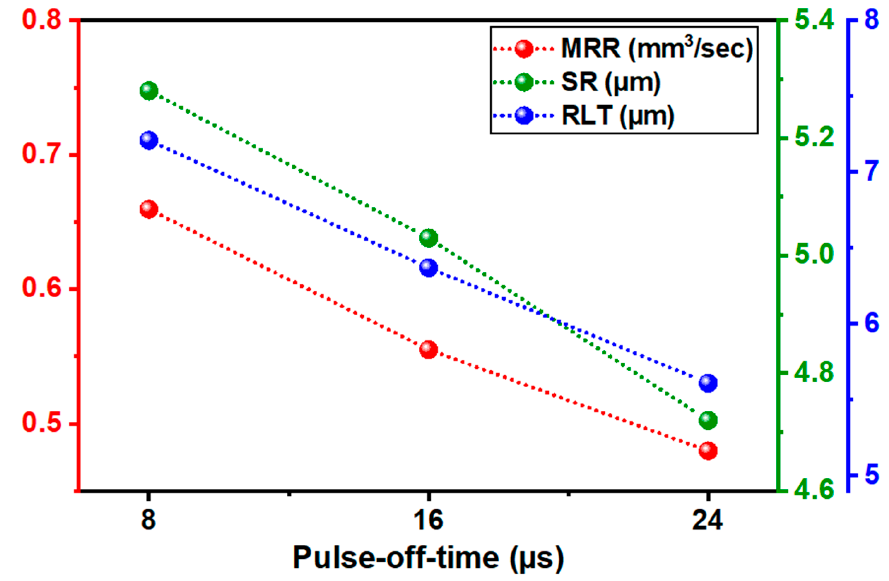
Figure 4. Effect of T off on MRR, SR, and RLT.